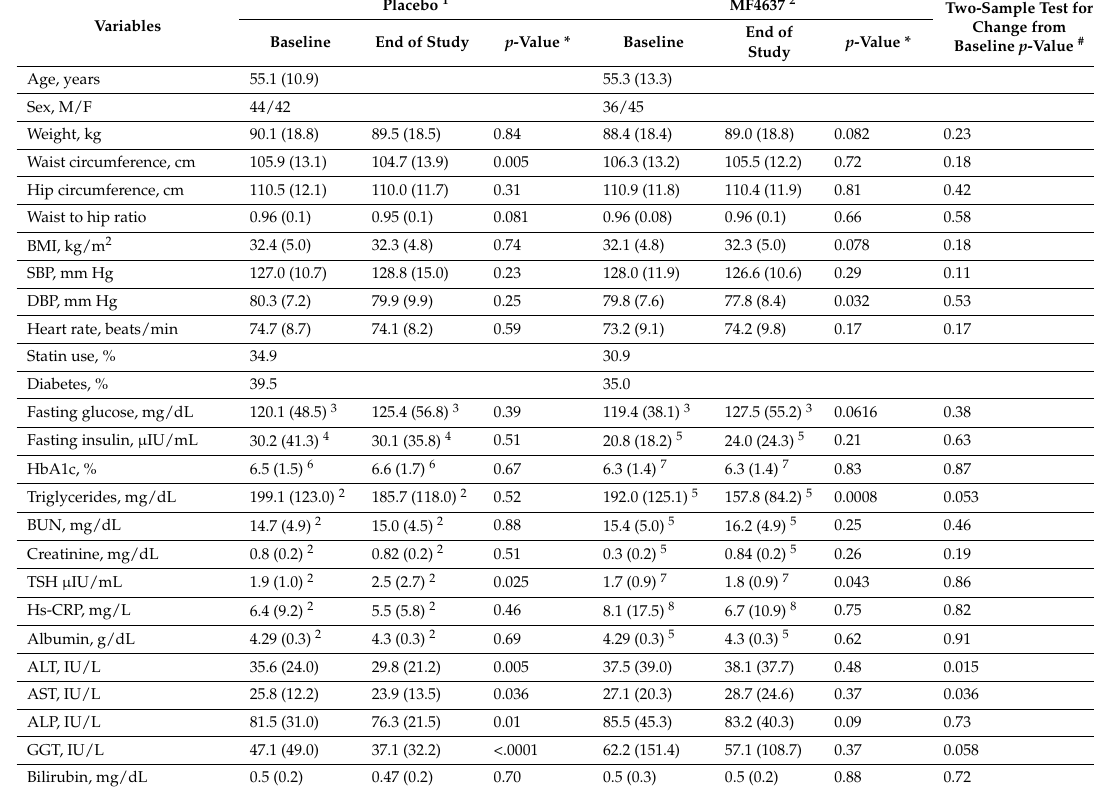
specified. 3 Data for n = 72 participants. 4 Data for n = 82 participants. 5 Data for n = 78 participants. 6 Data for n = 74 participants. 7 Data for n = 76 participants. 8 Data for n = 79 participants. Values are expressed as Mean (SD). Abbreviations: ALP, alkaline phosphatase; ALT, alanine aminotransferase; AST, aspartate aminotransferase; BMI, body mass index; BUN, blood urea nitrogen; DBP, diastolic blood pressure; GGT, gamma-glutamyl transferase; HbA1c, glycated haemoglobin; hs-CRP, high-sensitivity C-reactive protein; SBP, systolic blood pressure.* Within-group differences were assessed using paired t -tests or Wilcoxon signed rank tests. # Intergroup differences were assessed using two-sample t -tests or two-sample Wilcoxon